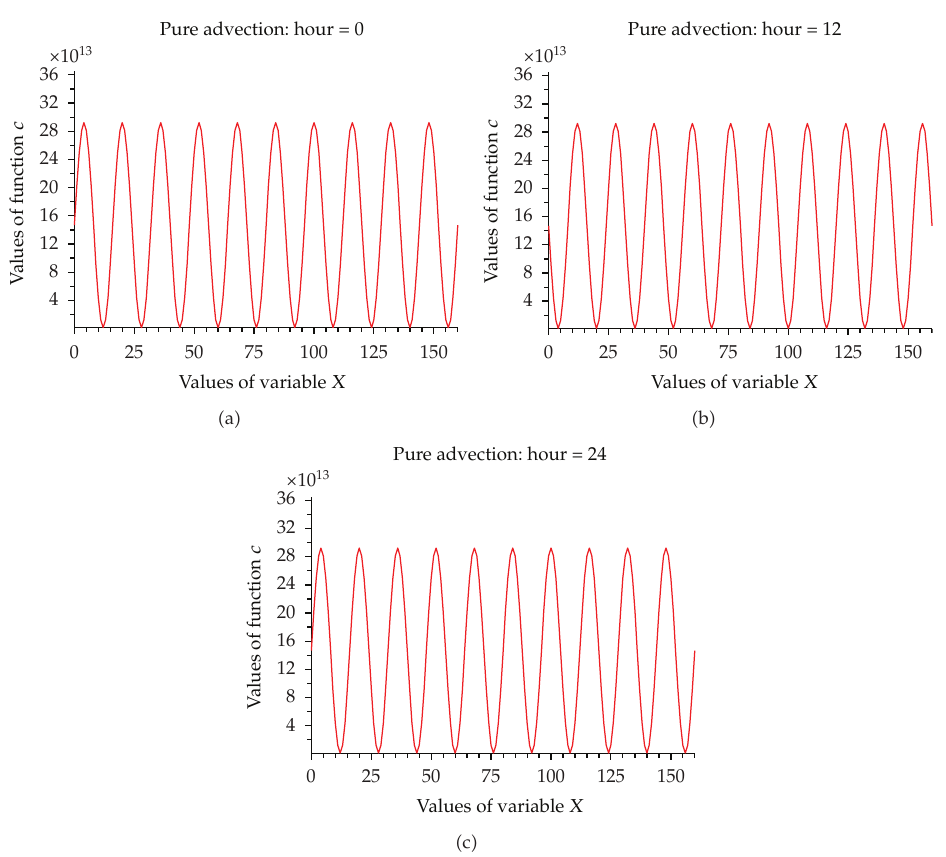
Figure 2: The solution of the one-dimensional advection equation defined in Section 5.3 is drawn (cid:6) a (cid:7) at the beginning of the interval (cid:6) the upper plot (cid:7) , (cid:6) b (cid:7) at the end of the twelfth hour (cid:6) the plot in the middle (cid:7) , and (cid:6) c (cid:7) at the end of the time interval (cid:6) the lower plot (cid:7)